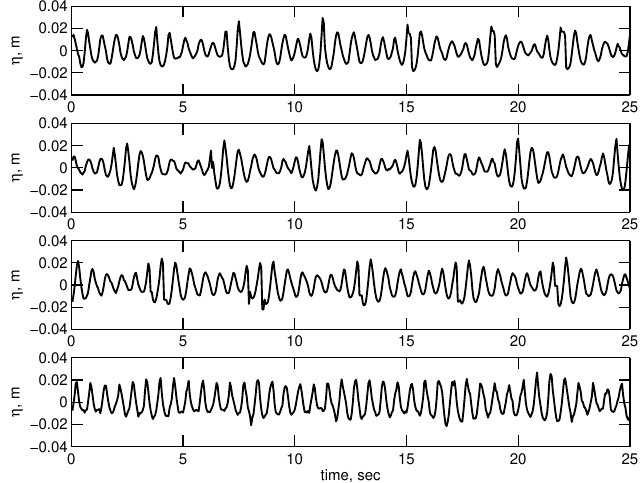
Figure 2. Time series of surface elevations η measured at the second wave probe, f 0 = 1.6 Hz. (top panel) ε 0 = 0.31, U / c = 0. (second top panel) ε 0 = 0.25, U / c = 0. (second bottom panel) ε 0 = 0.23, U / c = 0. (bottom panel) ε 0 = 0.23, U / c = 11. The waves propagate from right to left. Reproduced from